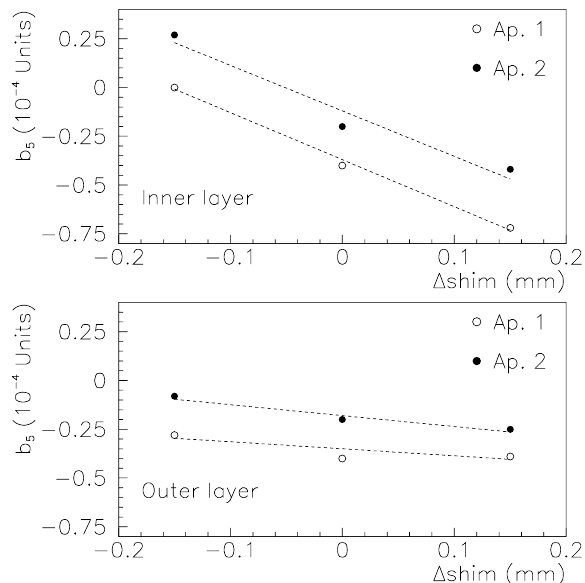
FIG. 8. b 5 ( 10 2 4 units) versus shim thickness variation (mm) for the inner and outer layers and for the two apertures (Ap. 1 and Ap. 2), experimental data, and linear fit.